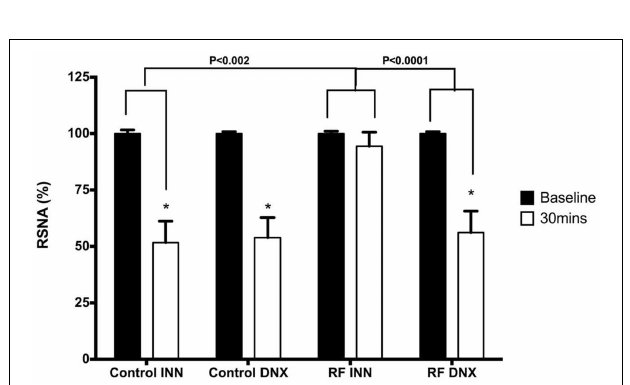
FIGURE 7 | This compares the changes in renal sympathetic nerve activity (RSNA) in response to the saline volume expansion at baseline (over the 5min prior to the start of infusion) and over the last 5min of the infusion (30min) in intact control (Control INN), control renally denervated rats (control DNX), intact cisplatin treated renal failure (RF) and renally denervated renal failure (RF DNX) groups of rats. Statistical analysis was performed using Two-Way ANOVA followed by Tukey’s post hoc test. Data presented as mean SEM. ( n = 12 for all groups). * P < 0 . 001 against baseline. P -value for interaction <